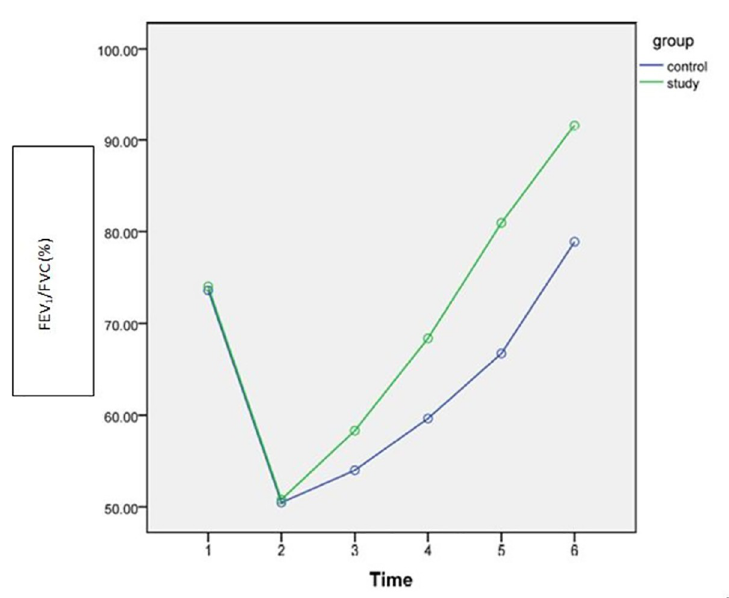
Fig 4. Estimated marginal means of FEV 1 /FVC [1: Pre-operative; 2: POD3; 3: Discharge; 4: 4 th POW; 5: 8 th POW; 6: Follow-up].